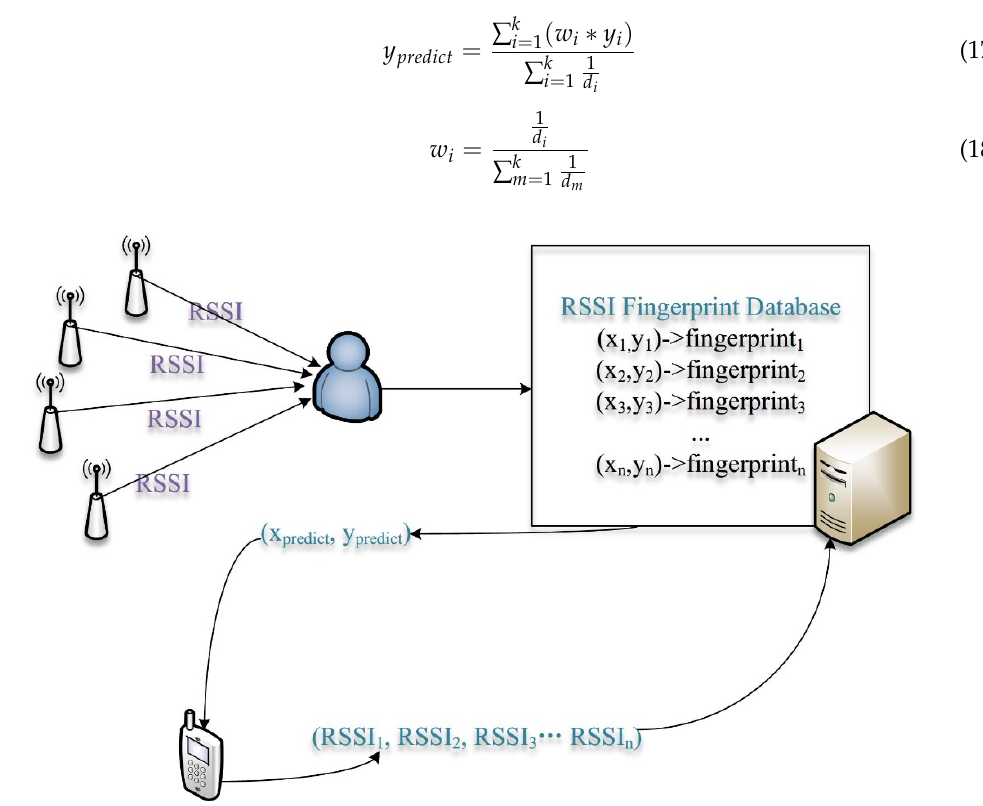
Figure 2. The establishment of RSSI fingerprint database.